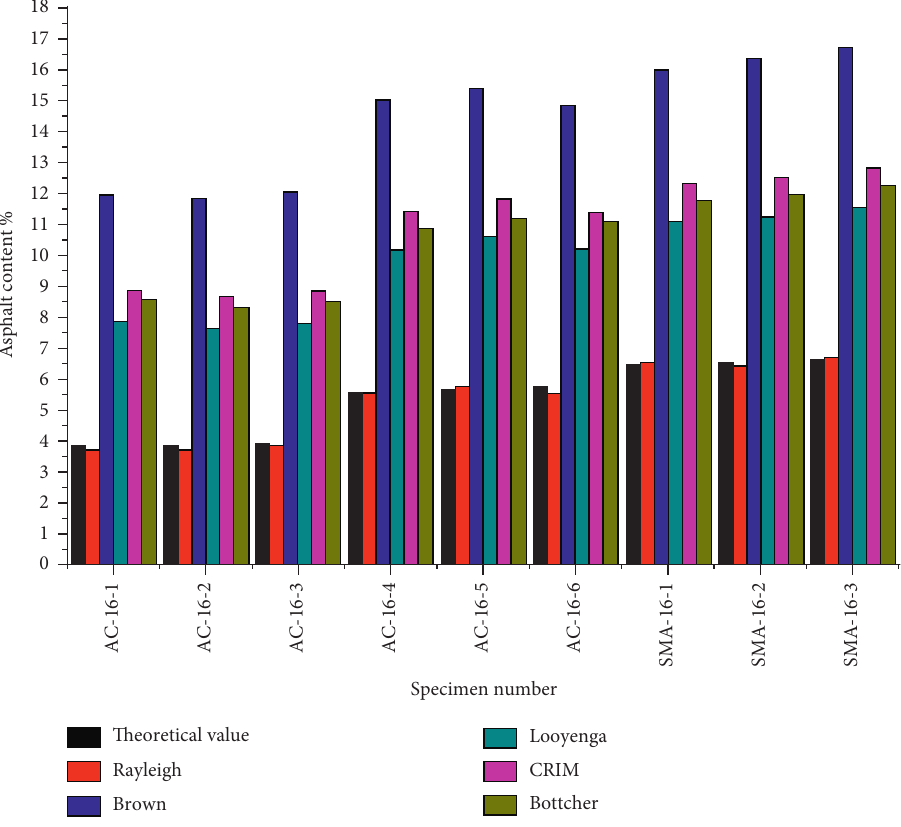
Figure 5: Comparison between prediction model and theoretical value.